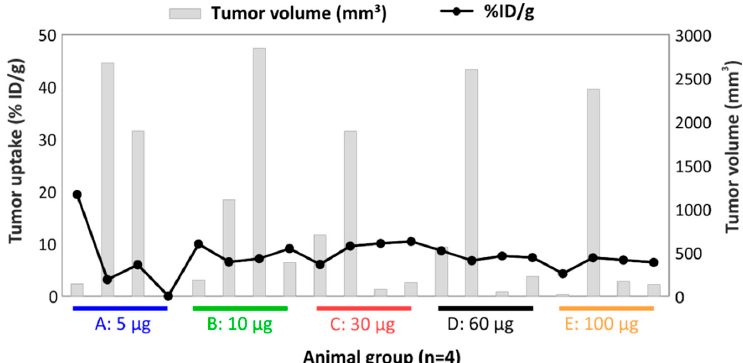
Figure 7. Relationship between tumor uptake and tumor volume per animal of the biodistribution of [ 177 Lu]DOTA(SCN)-cG250 from conjugate C7 at 48 h using total protein dose adjusted between 5 and 100 µ g and 12 MBq per animal ( n =